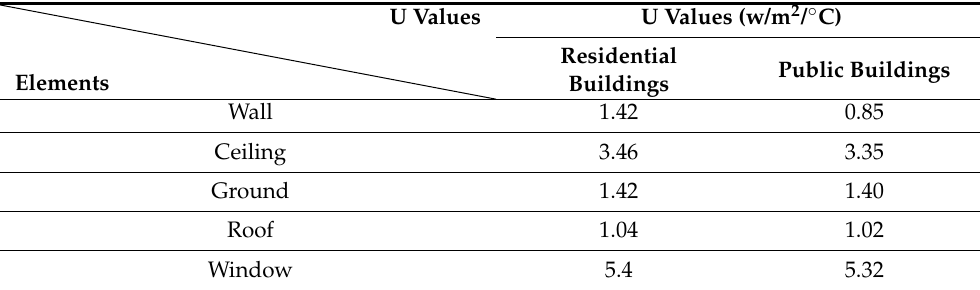
Table 3. Thermal insulation levels for residential and public buildings in this